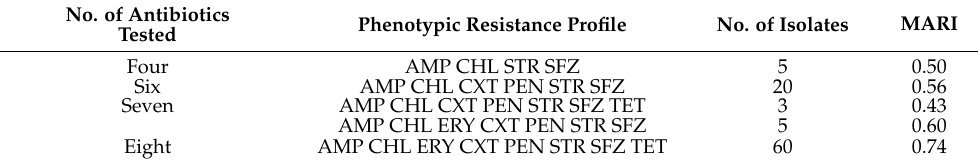
Table 2. Phenotypic antibiotic resistance profile of E. coli isolates from poultries in Sierra Leone 2021.